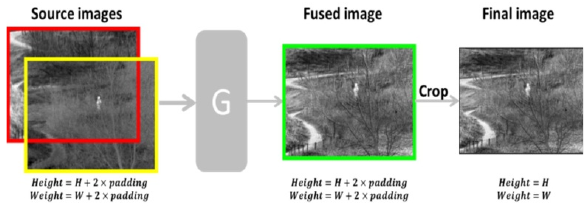
Figure 6. The image cropping of the testing process.